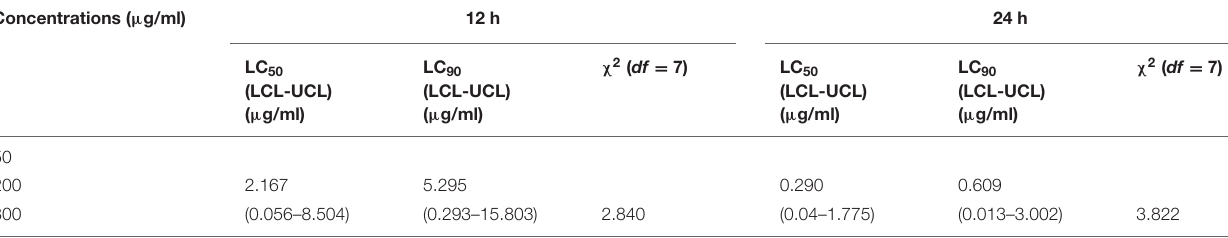
TABLE 2 | Biotoxicity of P. daleae mycelia ethyl acetate extract on Artemia nauplii .